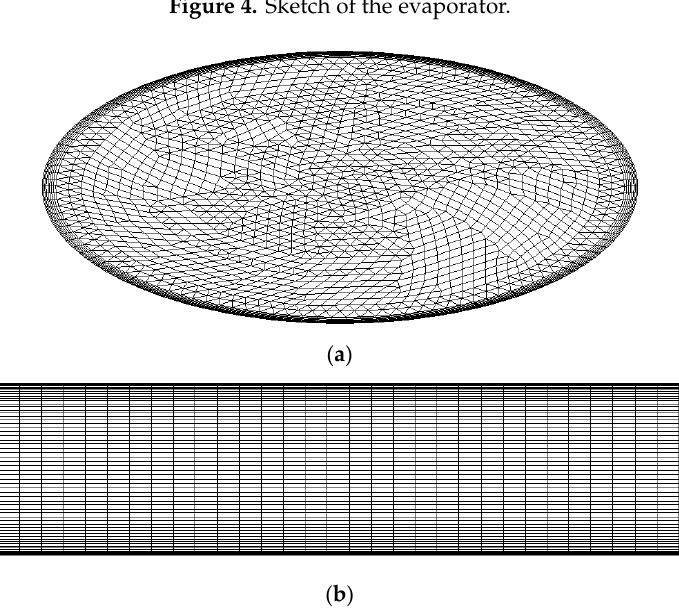
Figure 4. Sketch of the evaporator.